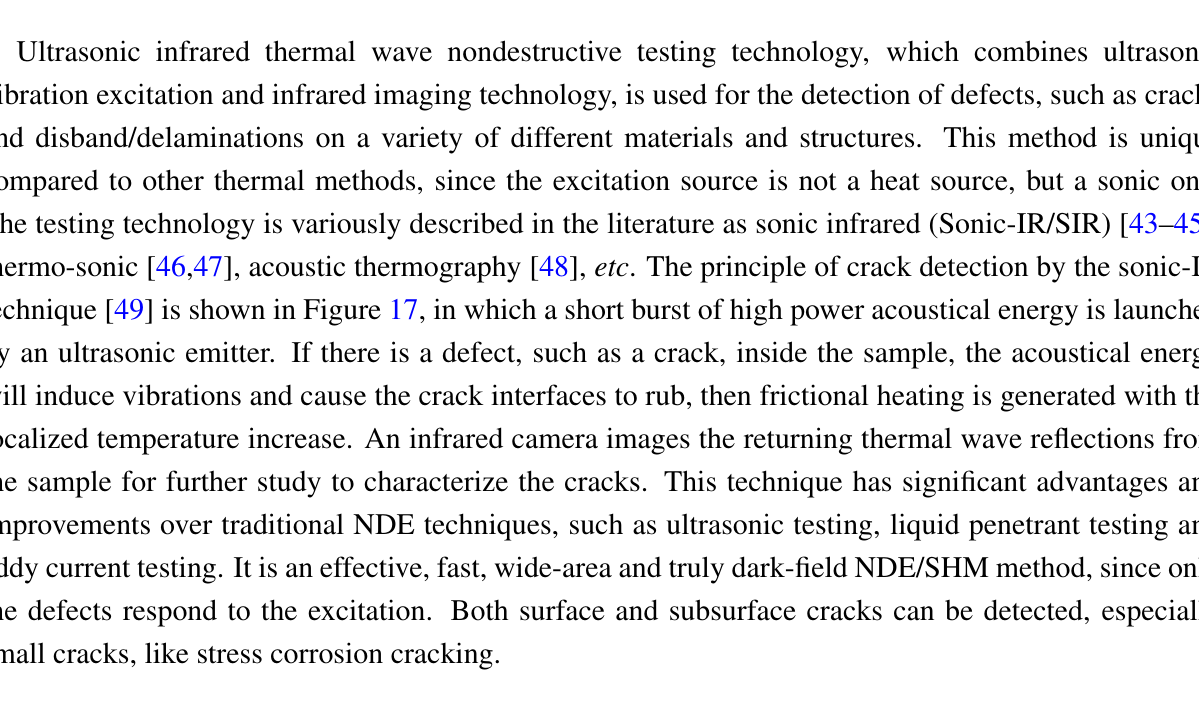
Figure 17. Principle of crack detection by the sonic infrared (IR)